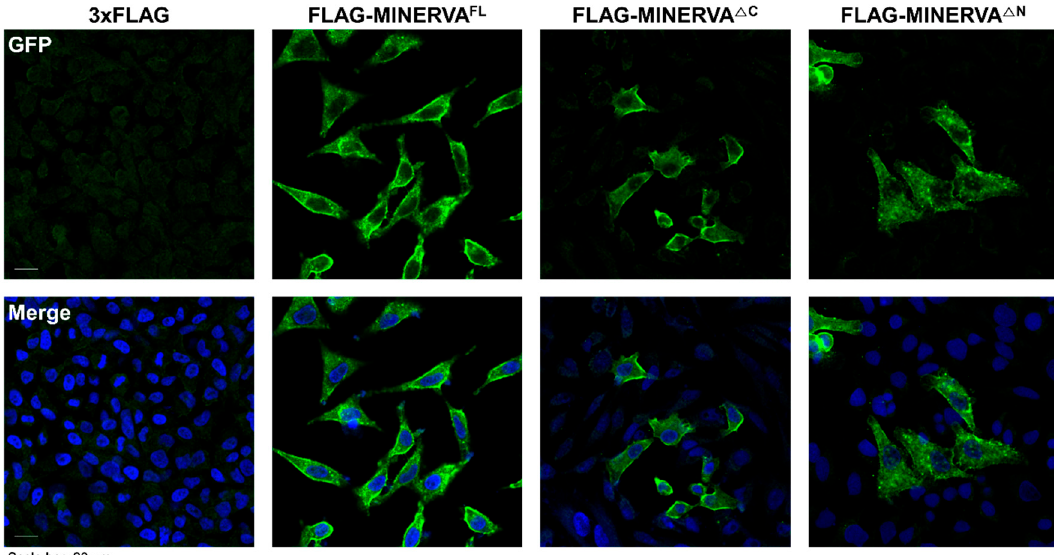
Figure 4. Sub-cellular localization of truncated MINERVA. After incubating HeLa cells for overnight, FLAG (DYKDDDDK)-tagged MINERVA FL , MINERVA ∆ C , and MINERVA ∆ N were transfected into cells, respectively, by standard manufacturer’s protocol and further incubated for 48 h. Cells were fixed and stained with a Hoechst 33342 for DNA and with antibody against FLAG-epitopes for immunofluorescence analysis. The secondary antibody used was goat anti-rabbit IgG Alexa Fluor 488. Subsequently, the subcellular localizations of MINERVA constructs were monitored by confocal fluorescence microscopy. The data are representative images from 10 different images at least three independent experiments. Scale bar: 20 μ m.